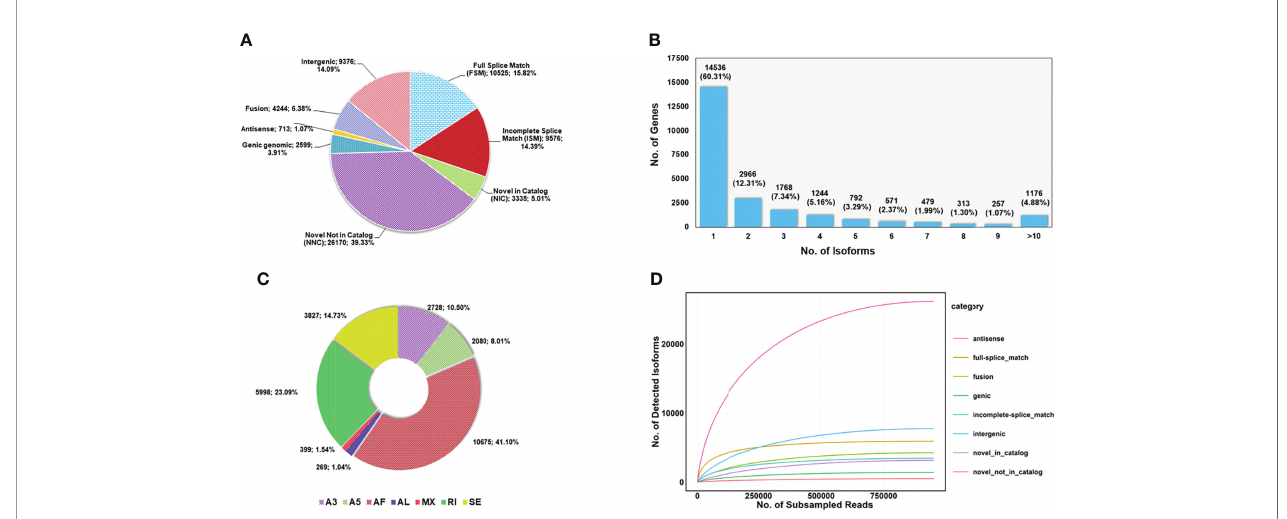
FIGURE 1 | Description of isoform-level transcript features in the M. cephalus transcriptome. (A) Different categories of isoforms identi fi ed in M. cephalus transcriptome. (B) Bar plot indicating the number of genes in the M. cephalus transcriptome capable of producing single or multiple isoforms. (C) Various types of alternative splicing events discovered for genes in the M. cephalus transcriptome. (D) Rarefaction curve depicting the sequencing depth required for the discovery of different categories of